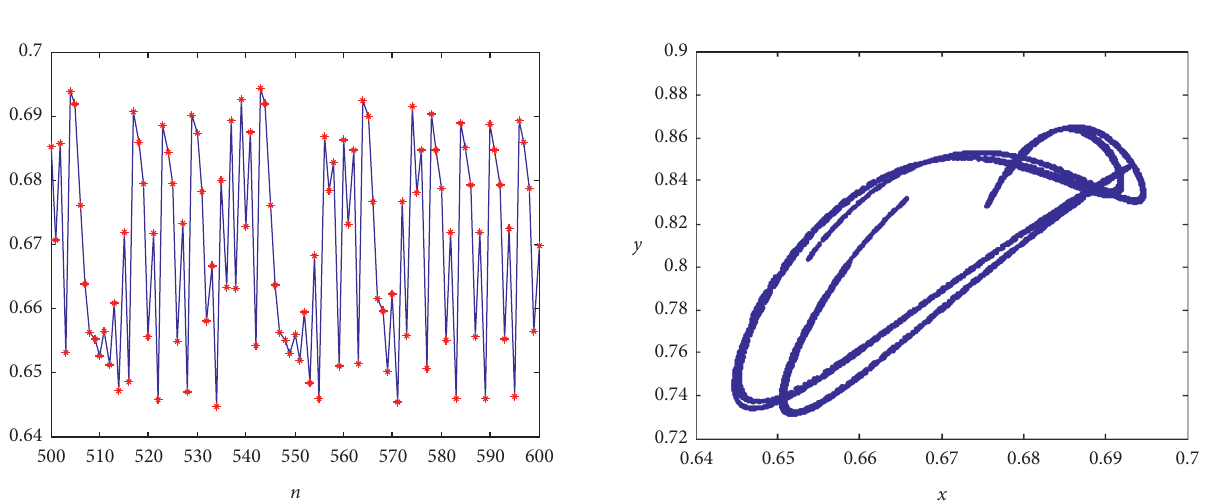
Figure 15: x - y phase diagram which denotes that the system is chaotic when β �